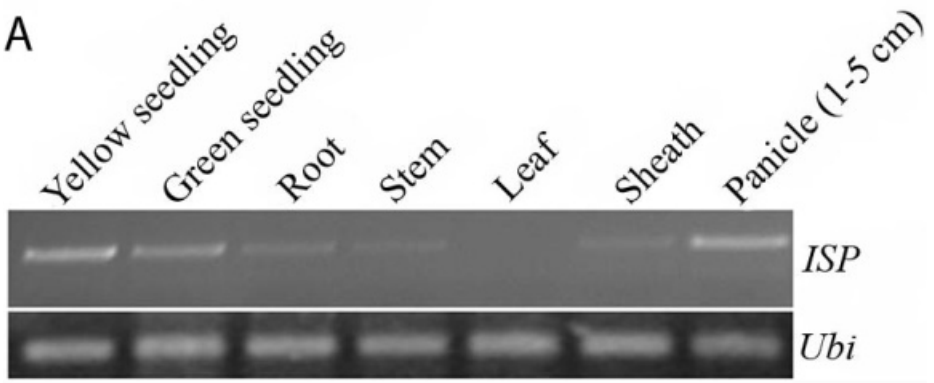
Figure 5. Gene expression pattern analysis of ISP . ( A ) Relative expression of ISP by real-time polymerase chain reaction (RT-PCR) analysis. Amplification of the rice Ubiquitin gene ( Ubi ) was used as a control; and ( B ) Quantitative RT-PCR analysis of ISP expression in green and yellow seedling of Zhonghua 11 (ZH11) and 93-11